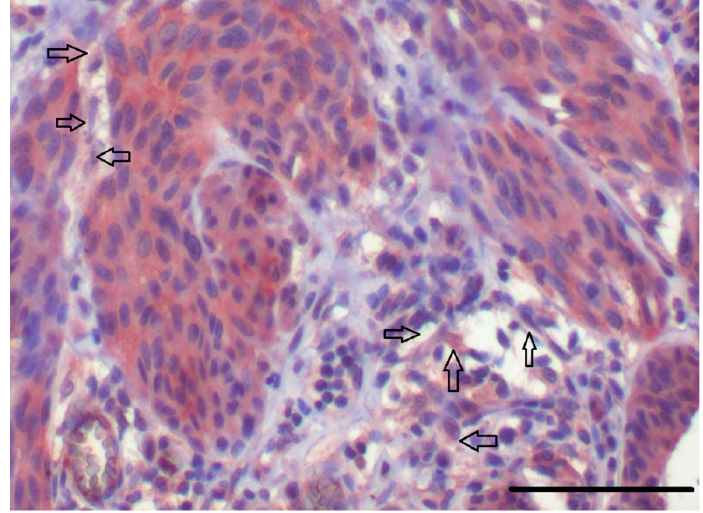
Figure 2. Positive immunohistochemical detection of IL-6 in human cutaneous malignant melanoma. Nests of melanoma cells are highly positive for IL-6 (in brown). Stromal cells, including representatives of CAFs (arrows), are also somewhat positive in this staining. The bar is 100 μ m.